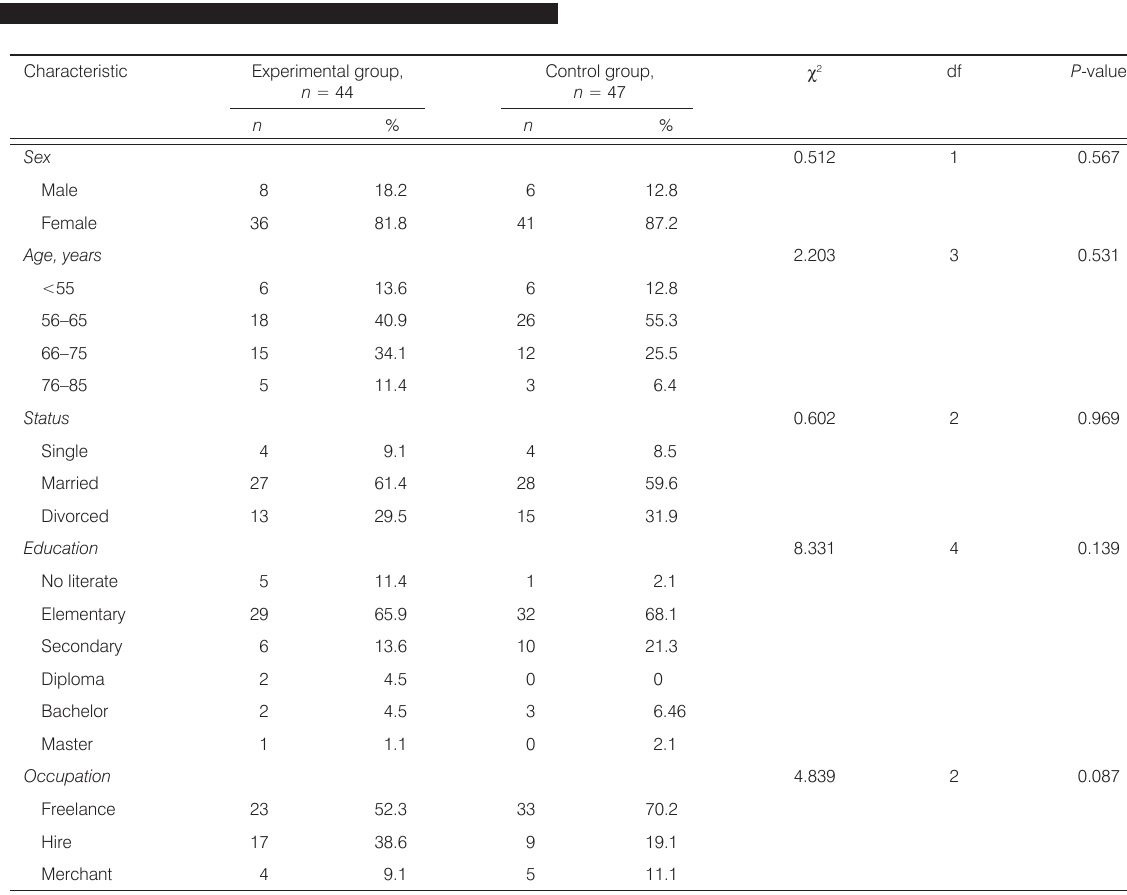
Table 1. Participant characteristic.